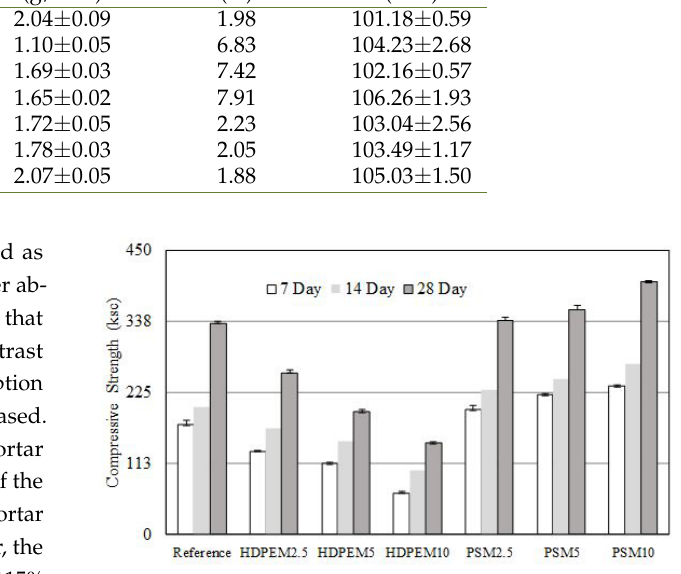
Fig. 5. Compressive strength of the investigated